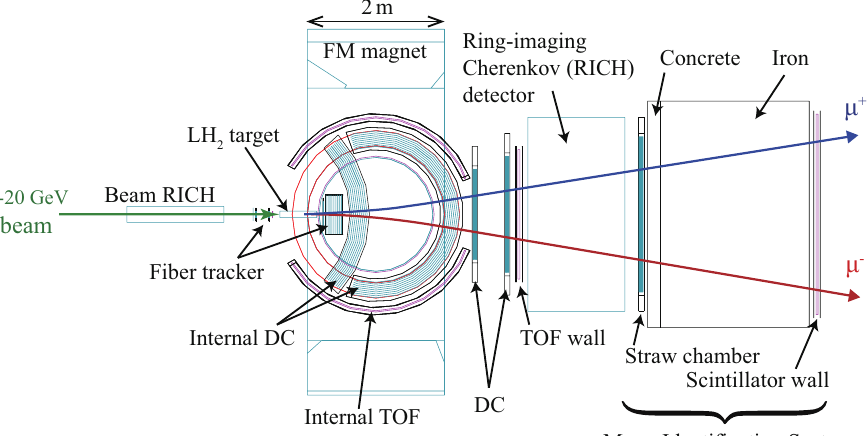
Figure 14. Detector design for the J-PARC GPD experiment